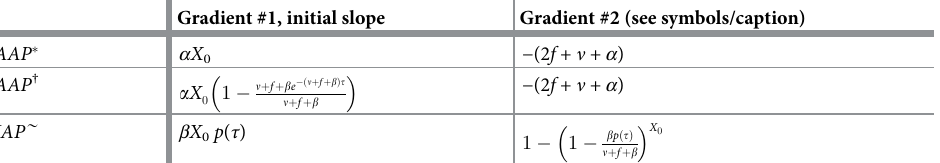
Table notes AAP � refers to acquisition response curve with molecular diagnostics; AAP † refers to acquisition response curve without molecular diagnostics; IAP * refers to inoculation response curve. Note that the inoculation response curve does not involve molecular diagnostics. In the case of: AAP � , Gradient #2 is the ratio of initial acceleration to initial slope; AAP † , Gradient #2 is the ratio of initial acceleration to initial slope plus scaled initial slope (scaled by ( X 0 − 1)/ X 0 ); IAP * , Gradient #2 is the